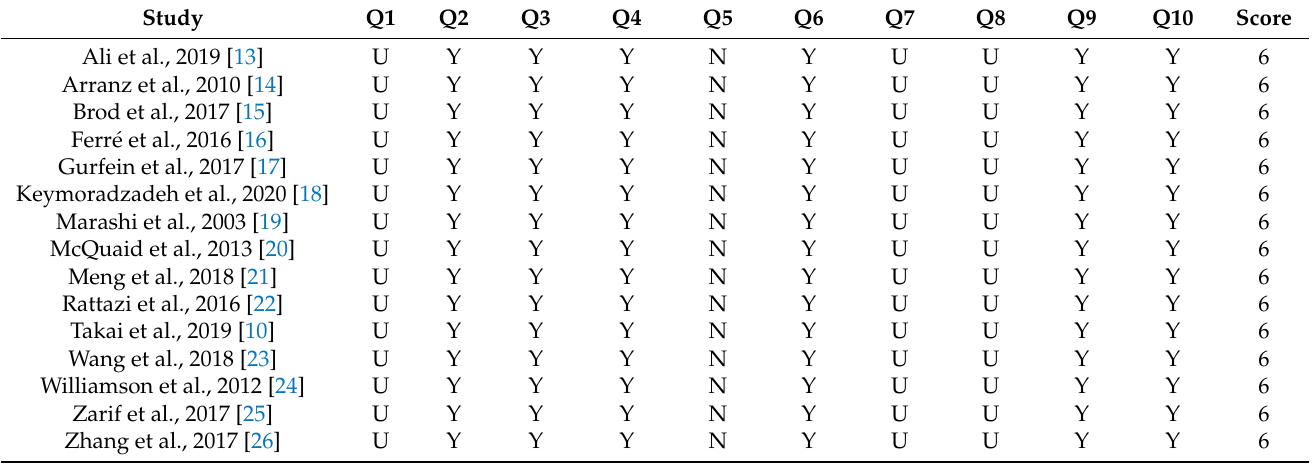
Table 3. Methodological Quality of Studies using the SYRCLE